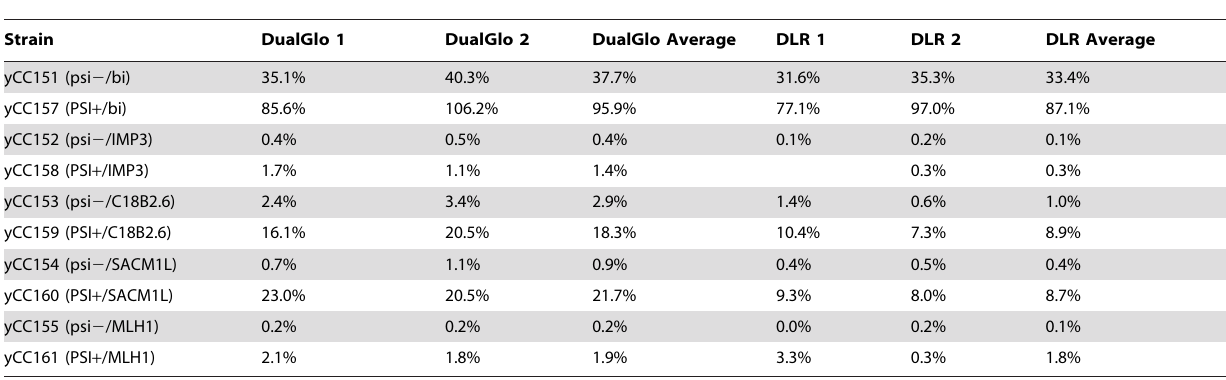
Figure 3. Readthrough Bar Plot. Percentage Readthrough is 100 times the ratio of Firefly luminescence (downstream reporter) to Renilla luminescence (upstream reporter), divided by this ratio for the full readthrough strain. doi:10.1371/journal.pone.0059450.g003 Table 4. Readthrough